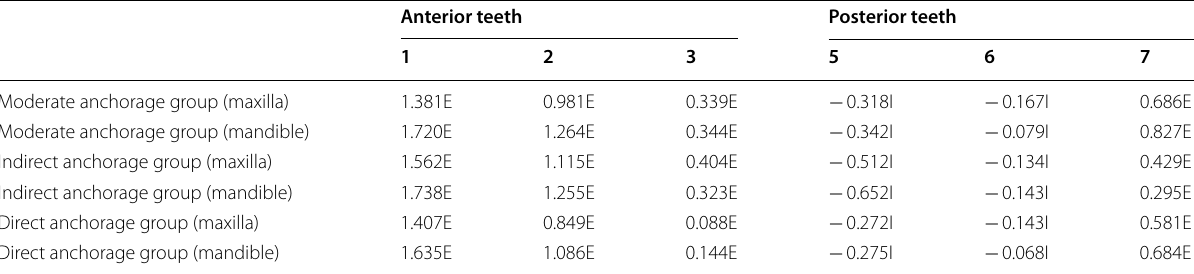
Table 3 Vertical movement of teeth in different groups